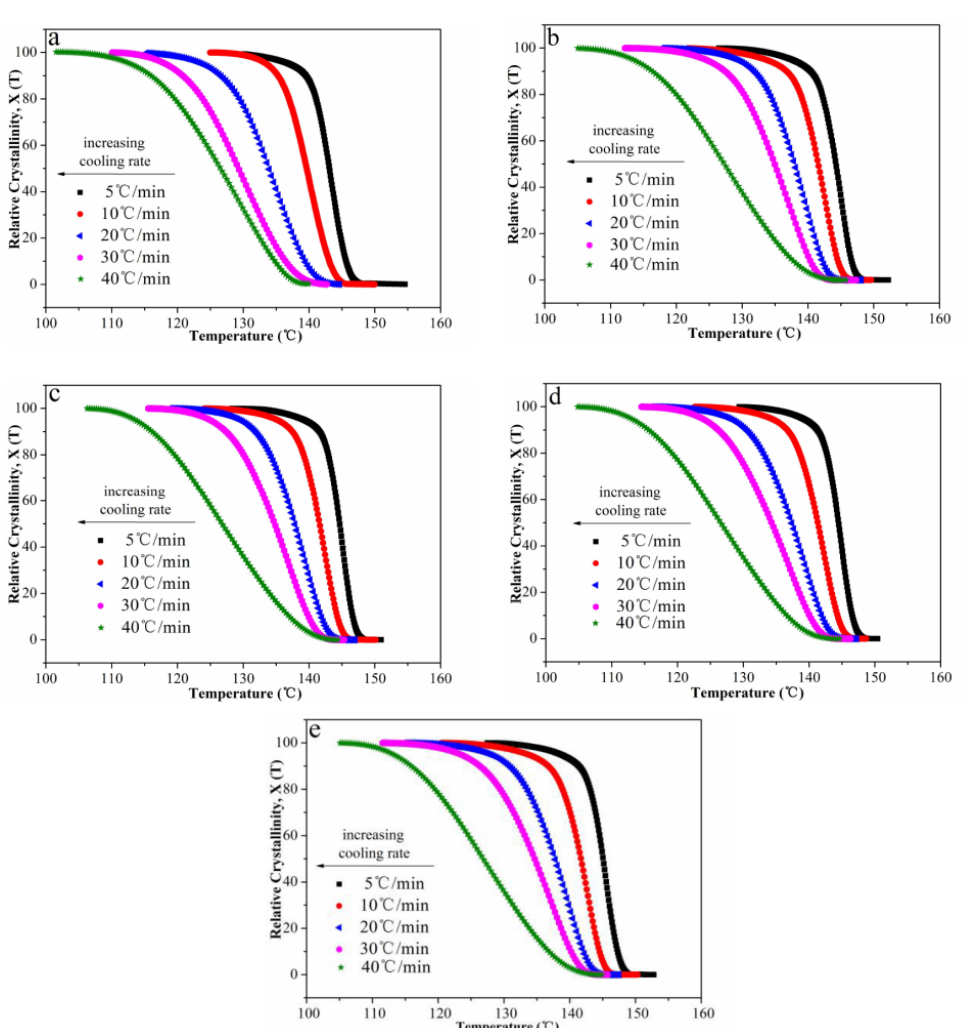
Figure 6. Relative degree of crystallinity as a function of temperature for POM / Ag nanocomposites with different Ag nanoparticle contents: ( a ) 0, ( b ) 0.1, ( c ) 0.5, ( d ) 1, ( e ) 2 wt % at the cooling rates of 5, 10, 20, 30 and 40 °C/min.